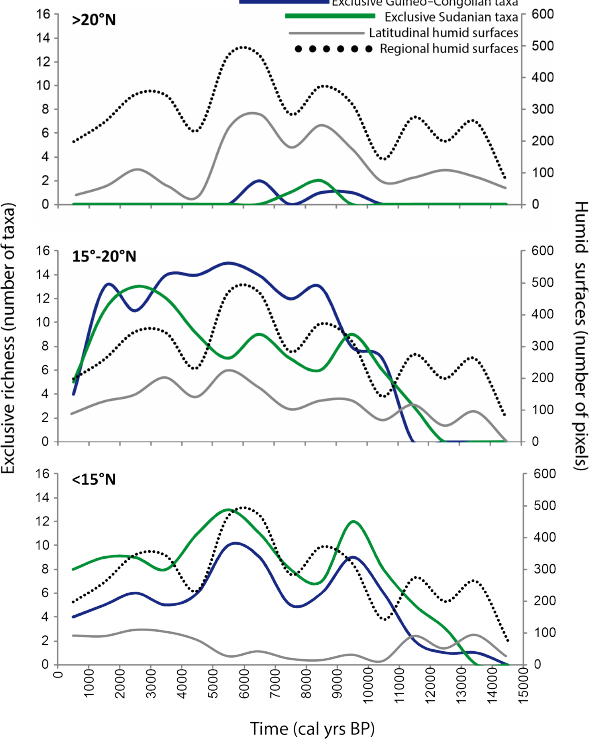
Fig. 4. Variation in the number of exclusive Guineo–Congolian and Sudanian pollen taxa compared to paleohydrological changes dur- ing the Holocene for each latitudinal zone and the entire studied area. Humid surfaces refer to the maximum extents of lacustrine and palustrine conditions estimated from the 0.85 isoprobability space at each 1000-year time interval. See Lézine et al. (2011a) for a dis- cussion on the representativeness of humid